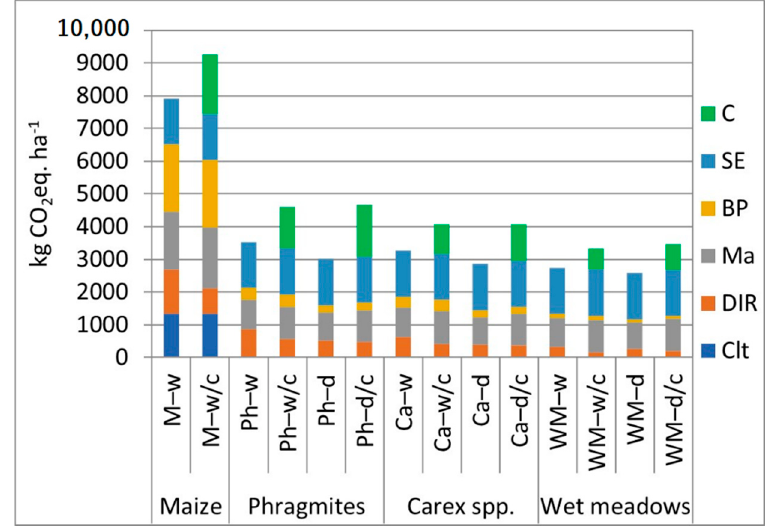
Figure 7. GHG emissions per hectare of feedstock; w—wet fermentation, d—dry fermentation, c— separation and composting of digestate; Clt—emissions from materials for cultivation, DIR— emissions from fuel, Ma—emissions from machinery production, BP—emissions from biogas plant operations, SE—emissions from soil after digestate/compost application, C—emissions from composting.